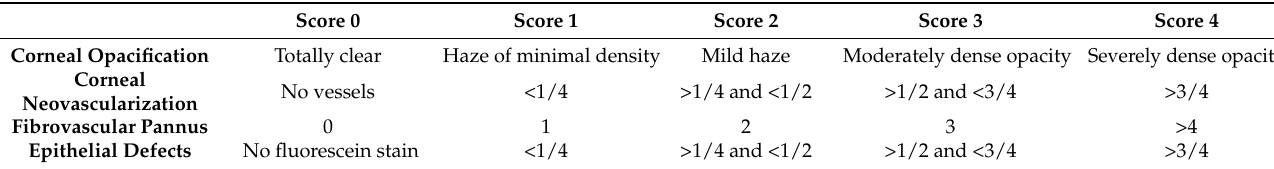
Table 4. Scores for clinical